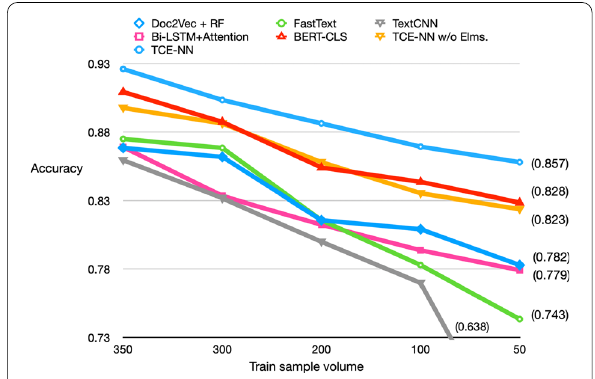
Fig. 6 Few-shot case evaluation on TTPs Obfuscated Files or Information . With the reduction of training samples, our TCENet still achieves considerable performance (0.875 ), even after training with 50